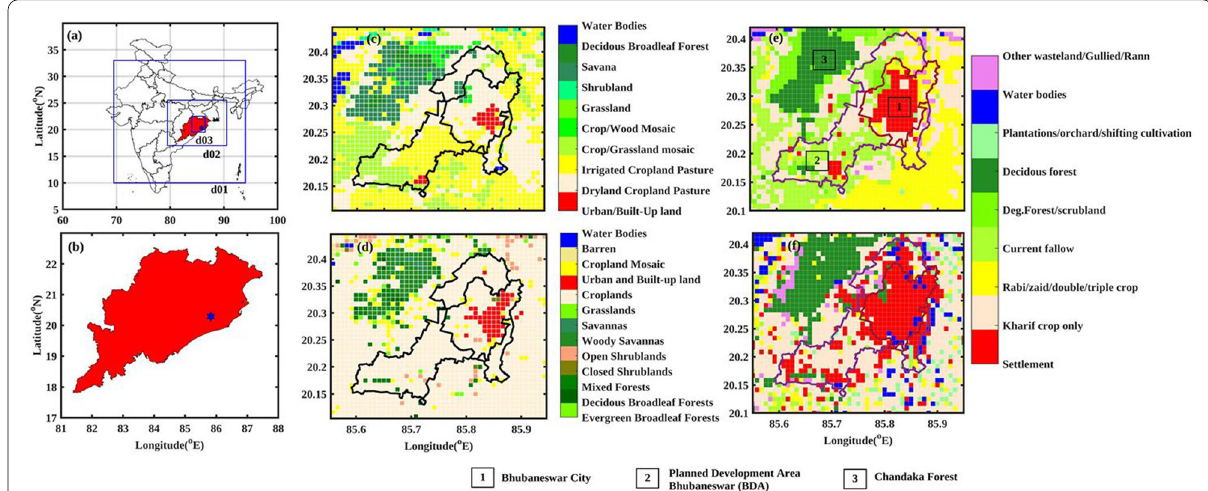
Fig. 1 Study location and the LULC changes over Bhubaneswar. a WRF model domain, domain 1(d01), domain 2(d02), and domain 3(d03) at the resolution of 36 km, 12 km, and 4 km, respectively. b The state of Odisha, Bhubaneswar, is marked as a blue star. The default ( c ) USGS LULC data, ( d ) MODIS LULC in the model and AWiFS LULC over Bhubaneswar during ( e ) 2004 and ( f ) 2015 at a resolution of 30